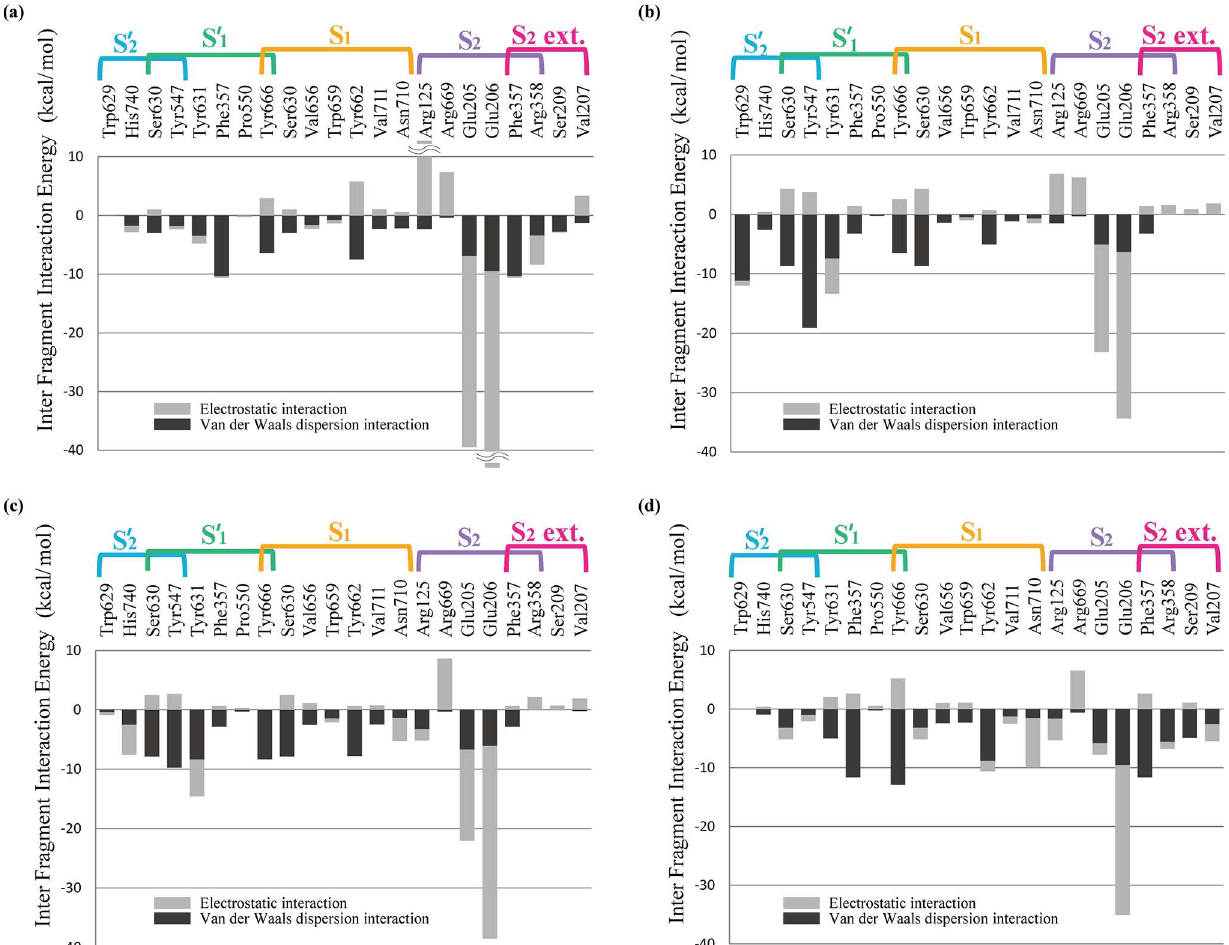
Fig 4. Interfragment interactionenergy (IFIE) between amino acid residues at the active site of DPP-4 and the inhibitors[(a) sitagliptin 1 , (b) linagliptin 2 , (c) alogliptin 3 , (d) teneligliptin 4 ]. The electrostatic (gray) and van der Waals (black) interaction energiesare shown separately.